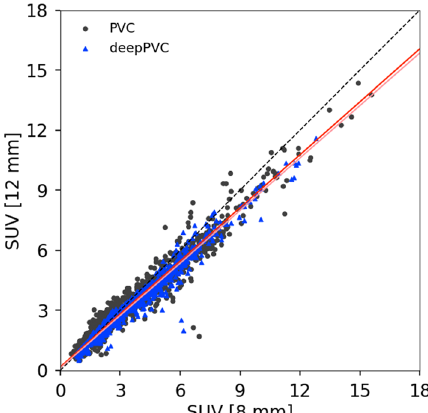
Fig. 7 Scatter plots of SUVs PV corrected with PET images, which had final resolutions of 8–12 mm FWHM by RBV PVC (gray circle) and deep PVC (blue triangle). Regression lines for RBV PVC and deepPVC are indicated with red and pink lines, respectively. FWHM, full width half maximum; PV, partial volume; PVC, partial volume correction; RBV, region-based voxel-wise; SUV, standardized uptake